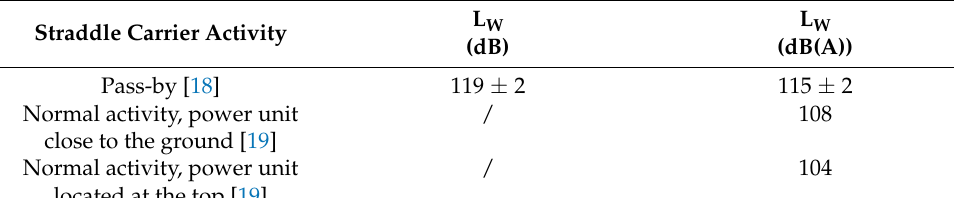
Table 1. Sound power level of straddle carriers as reported in [18,19].